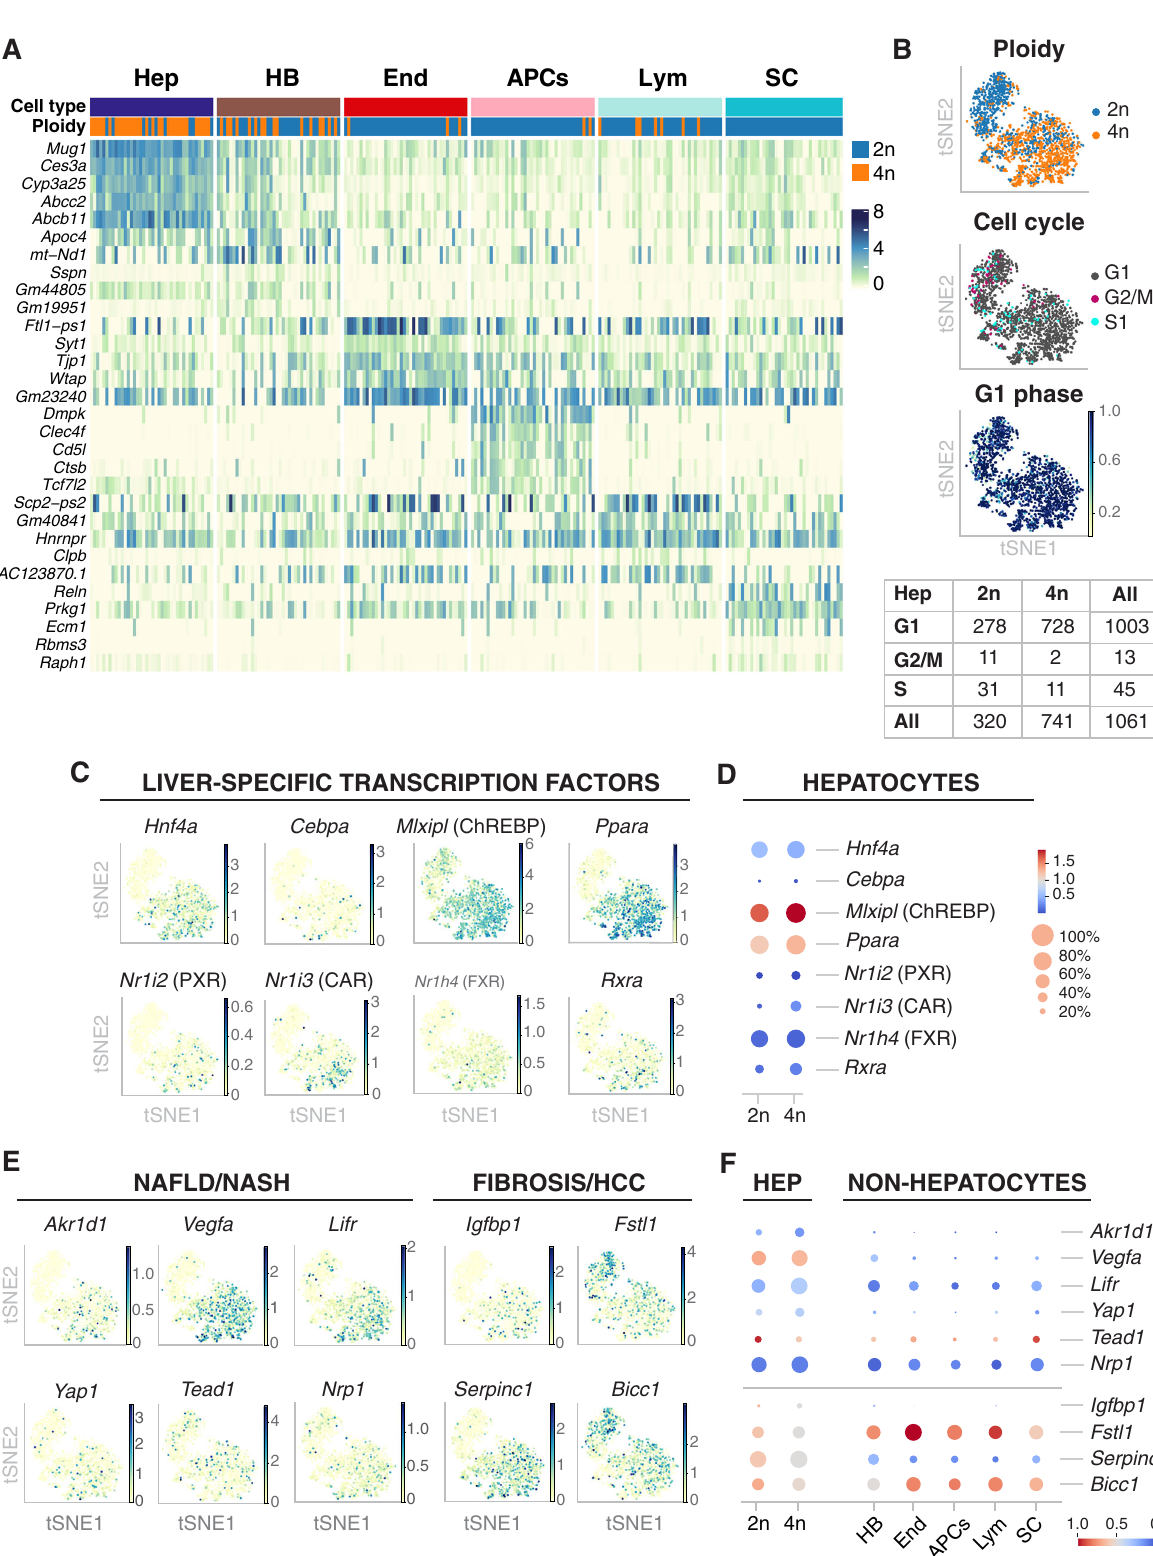
Fig. 6C, D and Supp. Dataset 5). Only two of the 248 genes upregulated in 4n had zero counts in the 2n population ( “ Methods ” and Supp. Fig. 6D, Supp. Dataset 5). Subsequently, the transcriptional variability was estimated as the coef fi cient of variation using log-transformed data 90 – 92 (Supp. Information). We con fi rmed that 4n hepatocytes showed a